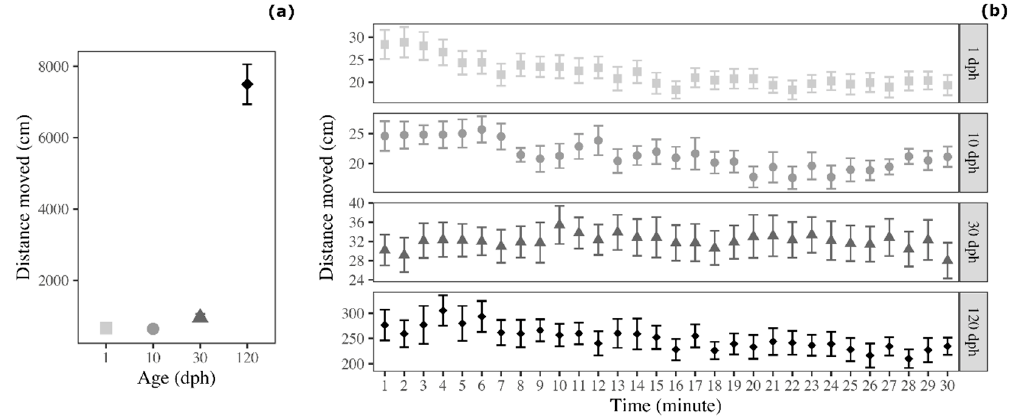
Figure 2. Distance moved by medaka in the open-field test ( a ) as a function of age and ( b ) as a function of age and time (30 1 min time bins). Points represent means of the different age groups (squares = 1 dph, circles = 10 dph, triangles = 30 dph, and rhombuses = 120 dph) and error bars represent standard errors ( n = 16 per age group).